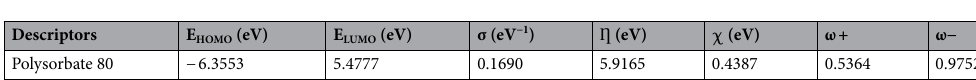
Table 1. Quantum chemical descriptors for polysorbate 80 in aqueous phases.